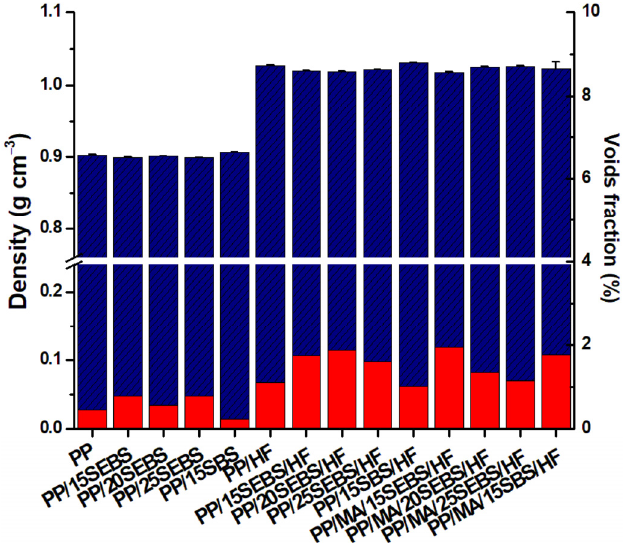
Figure 3. Density and voids fraction for the PP blends and composites.